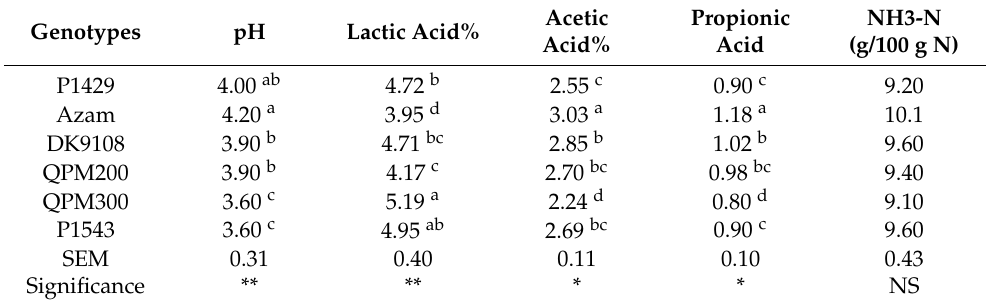
Table 5. Fermentation parameters of different maize genotypes for maize silage